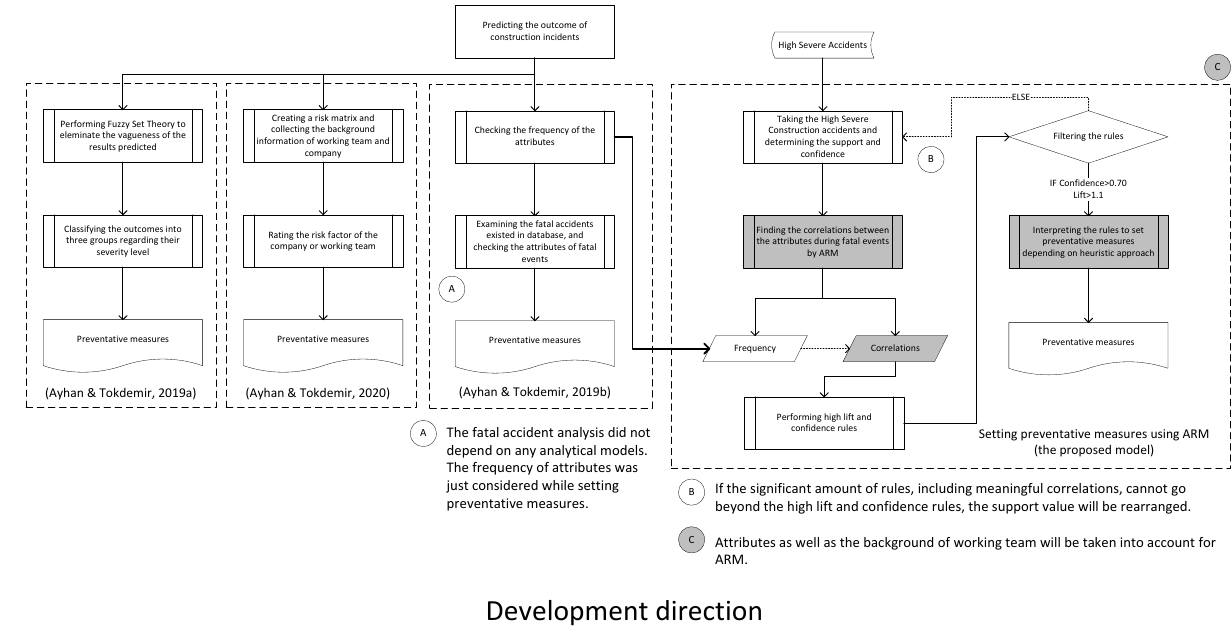
Figure 9. Contribution of the proposed